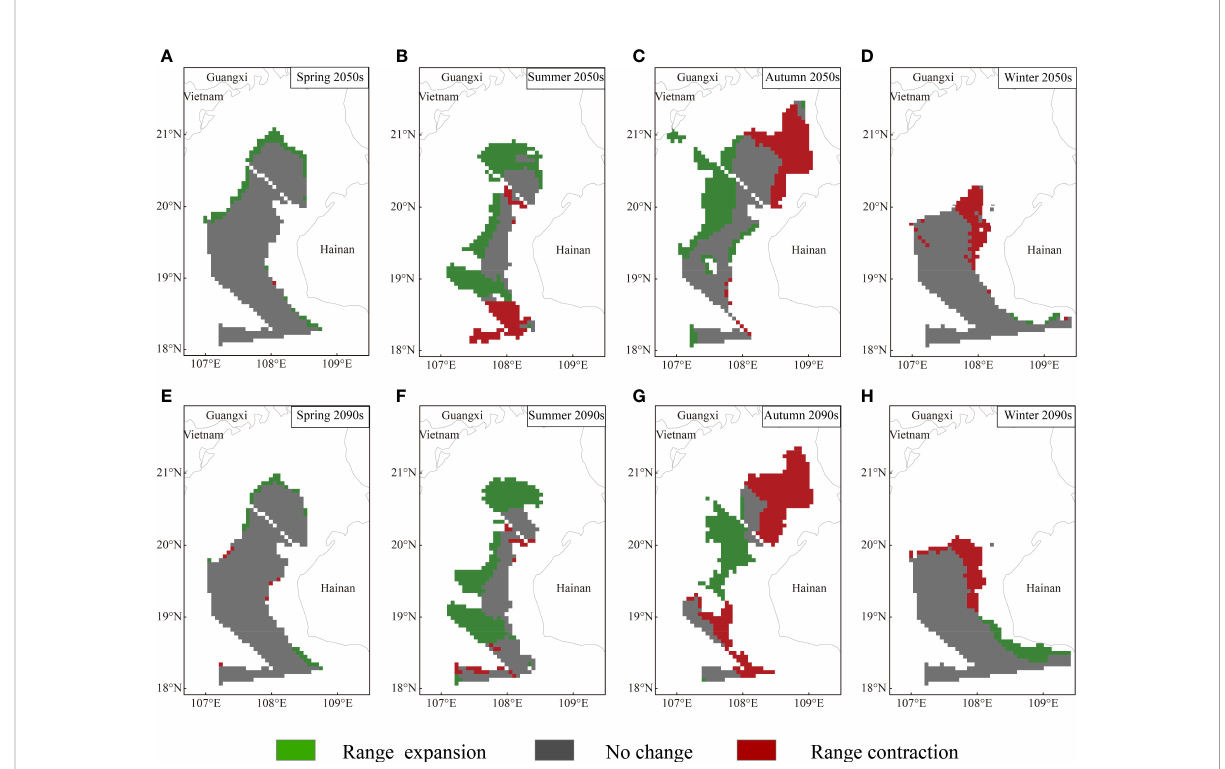
FIGURE 7 Projected range expansion or contraction for Trichiurus japonicus in the Beibu Gulf under RCP585. Area of geographic distribution changes among binary species distribution models based on binary predictions for current and future (i.e., in the 2050s and 2090s) climate conditions: (A) spring 2050s; (B) summer 2050s; (C) autumn 2050s; (D) winter 2050s; (E) spring 2090s; (F) summer 2090s; (G) autumn 2090s; (H) winter 2090s.